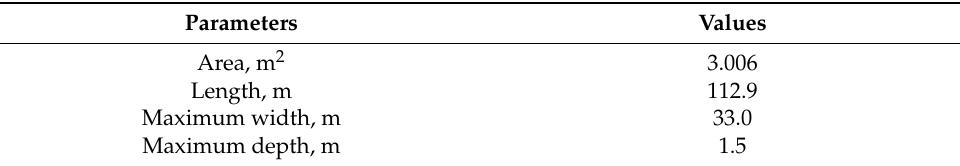
Table 1. Morphological characteristics of the lake.